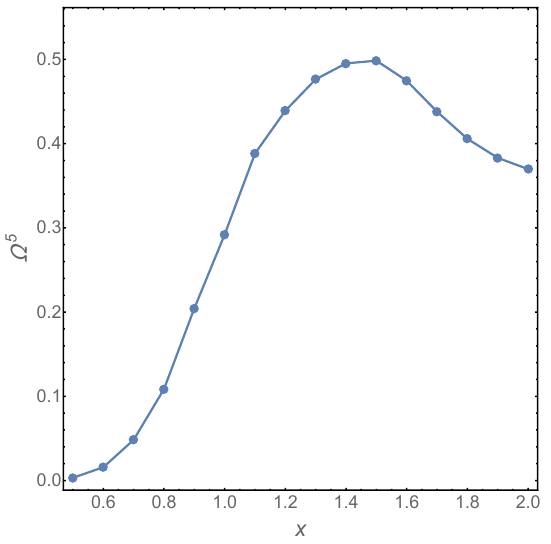
Figure 6 . Volume of 5D positive region Ω (5) with different x for γ = 1 . Ω (5) is greater when x is close to 1